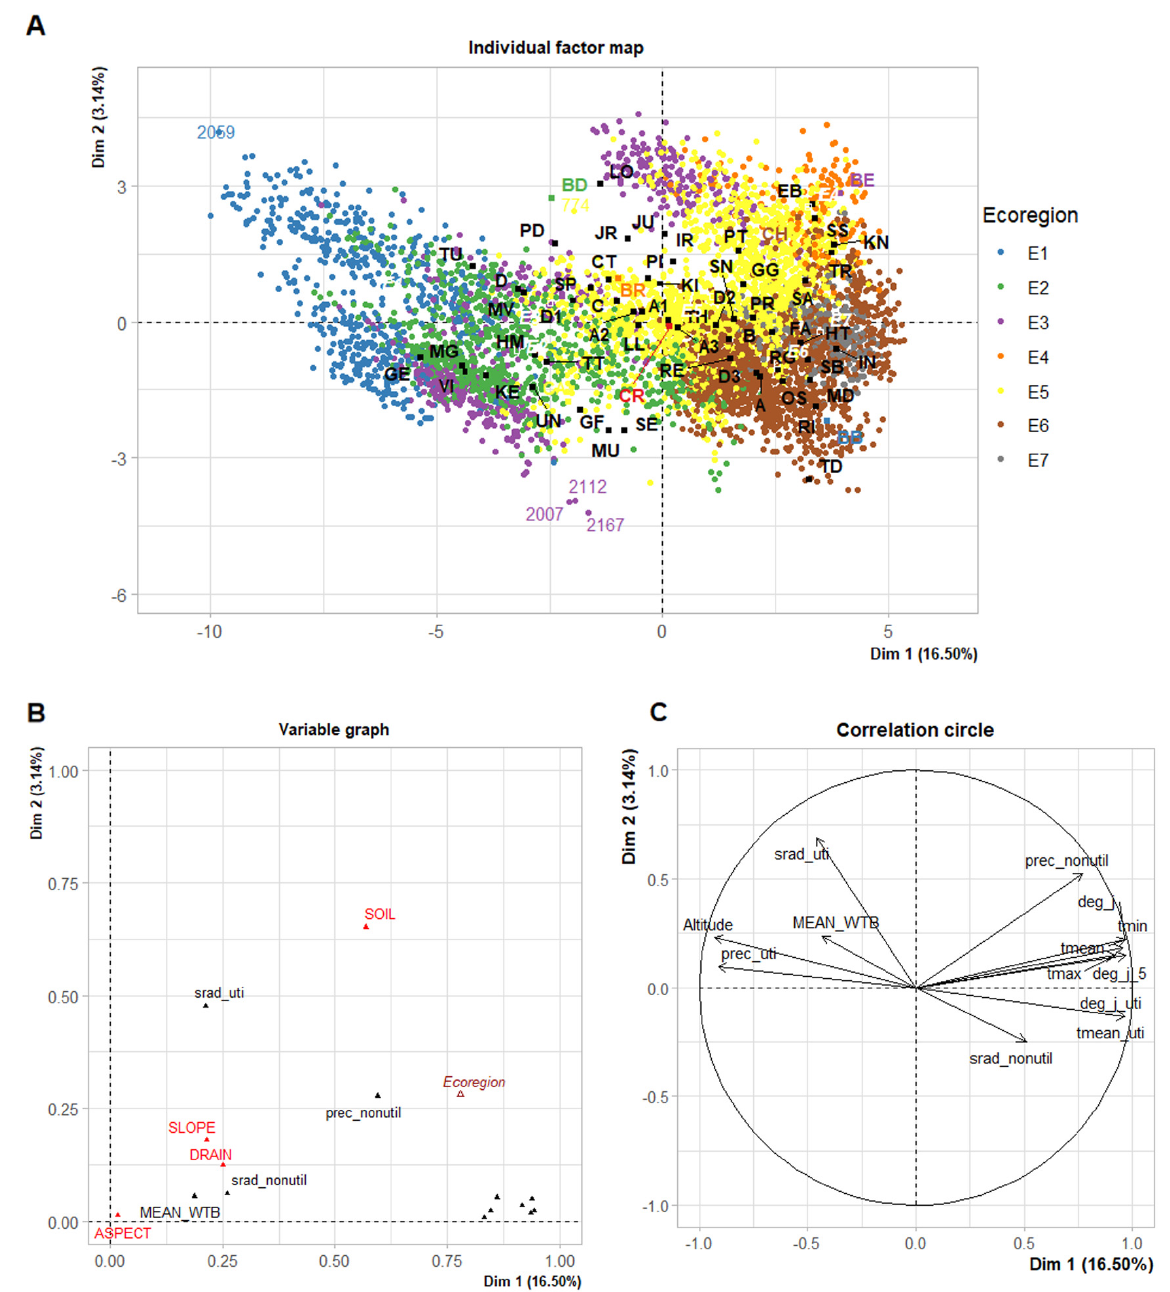
Figure 3. Individual factor map ( A ), variable graph ( B ), and correlation circle ( C ) for FAMD on ecoregions. Explanation of variables can be found in Table S1.